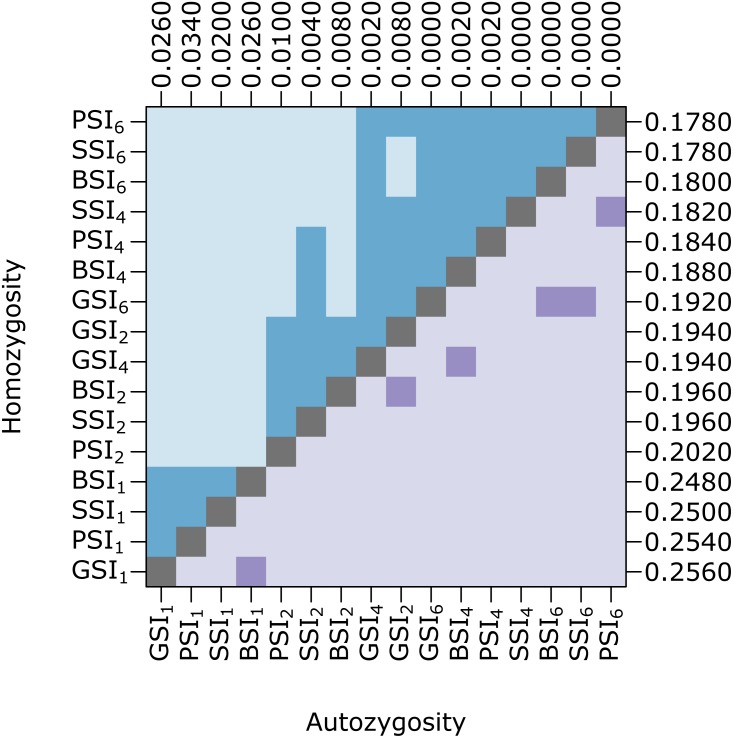
Biparental inbreeding avoidance in homomorphic SI systems was greater when isolation-by-distance was stronger.The plot shows pairwise comparisons for simulations of each SI system at different dispersal levels. The upper (blue) and lower (purple) triangles compare the distribution of proportions of homozygotes and autozygotes, respectively, in 500 samples from each simulation. The color of each square indicates the outcome of a Holm-corrected, pairwise Anderson–Darling test which determined whether the pair of distributions were significantly different (p < 0.05; light color) or not (dark color). The values along the right and top axes are the medians for homozygosity and autozygosity, respectively. The simulations are sorted on both axes by median homozygosity. The simulations included inbreeding depression and were run on a 100 ×100 landscape with pollen and seed dispersal parameters σ = 1, 2, 4, and 6, indicated in the subscript.